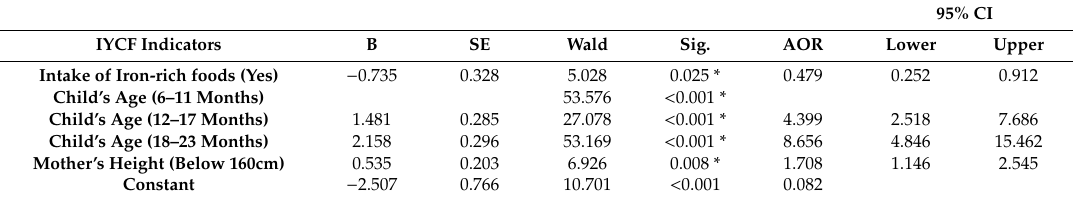
Table 6. Multivariable binary logistic regression analysis of predictors of